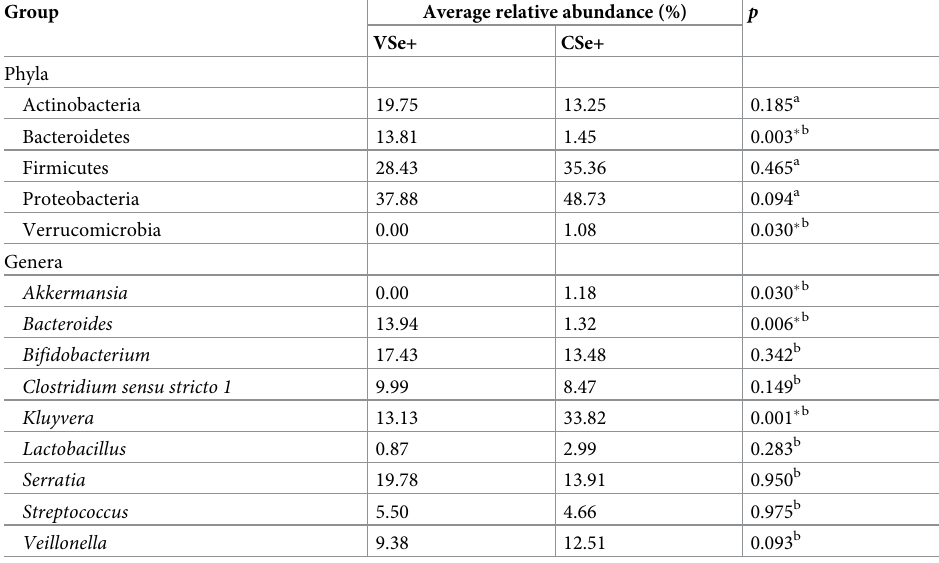
The most abundant taxa were those with an average relative abundance � 1%; VSe+: Vaginally born, secretor; CSe+: Cesarean born, secretor. p-values were adjusted for multiple comparisons using the Benjamini and Hochberg method a adjusted for age at inclusion using ANCOVA (analysis of